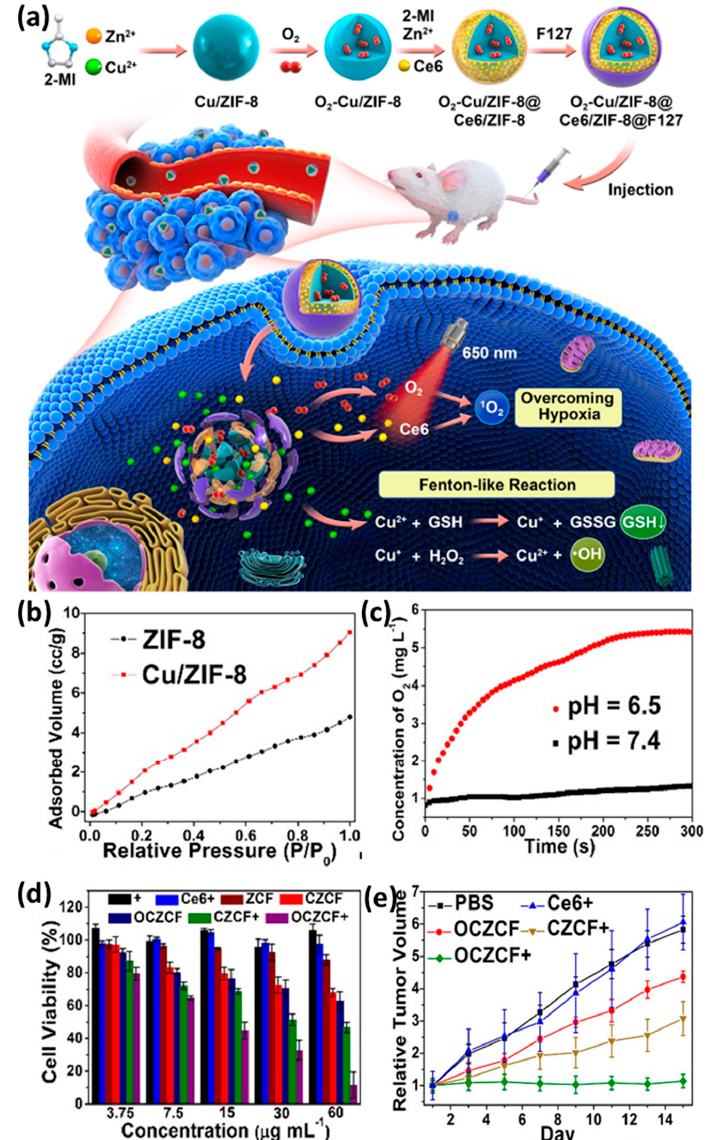
Figure 8. ( a ) Schematic illustration of the O 2 − Cu/ZIF − 8@Ce6/ZIF − 8@F127 (OCZCF) nanoplatform as a drug carrier for enhanced cancer therapy. ( b ) Oxygen adsorption property of ZIF − 8 and Cu − doped ZIF − 8. ( c ) Oxygen release isotherm of ZIF − 8. ( d ) Relative cell viability incubated with different MOF materials under normoxic or hypoxic conditions. ( e ) Relative tumor volume of tumor–bearing mice. Reproduced with permission from Ref. [124]. Copyright 2019, American Chemical Society.